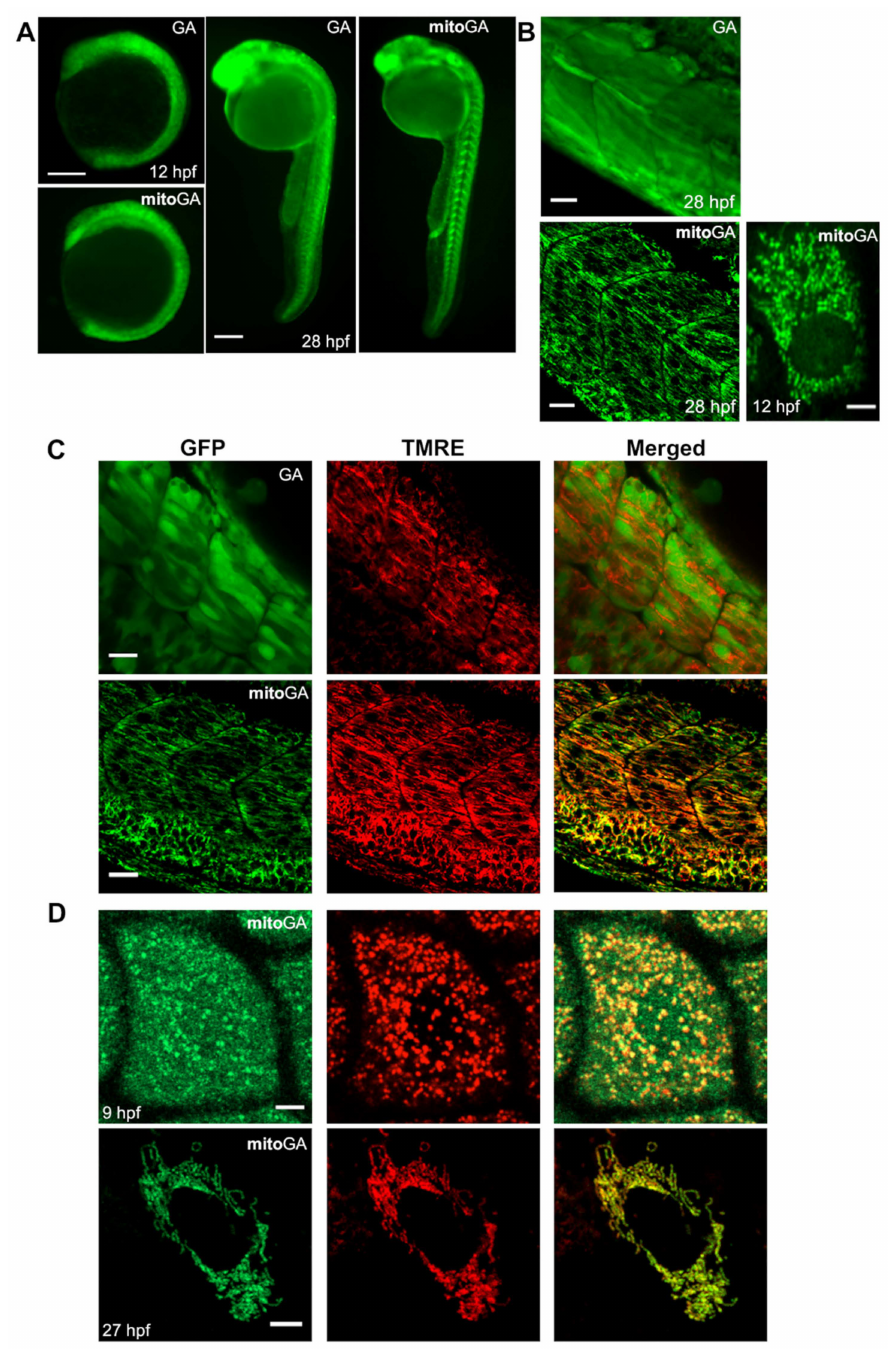
Figure 1. Expression of biosensors GFP-aequorin (GA) and mitoGA in zebrafish embryos. ( A ) Ubiquitous transient expression of GA and mitoGA in zebrafish at 12 and 28 hpf visualized with a fluorescence stereomicroscope. ( B ) Localization of GA and mitoGA expressed in the trunk musculature by confocal microscopy (28 hpf) and mitoGA in the enveloping layer (12 hpf). ( C ) MitoGA, but not GA, colocalizes with the mitochondrial marker TMRE in skeletal muscle at 28 hpf. ( D ) Colocalization of mitoGA with TMRE at 9 and 27 hpf in the cells of the enveloping layer of a zebrafish embryo. Mitochondrial import of mitoGA was complete at 27 hpf. The scale bars represent 200 µ m ( A ), 20 µ m ( B , C ) and 5 µ m ( D